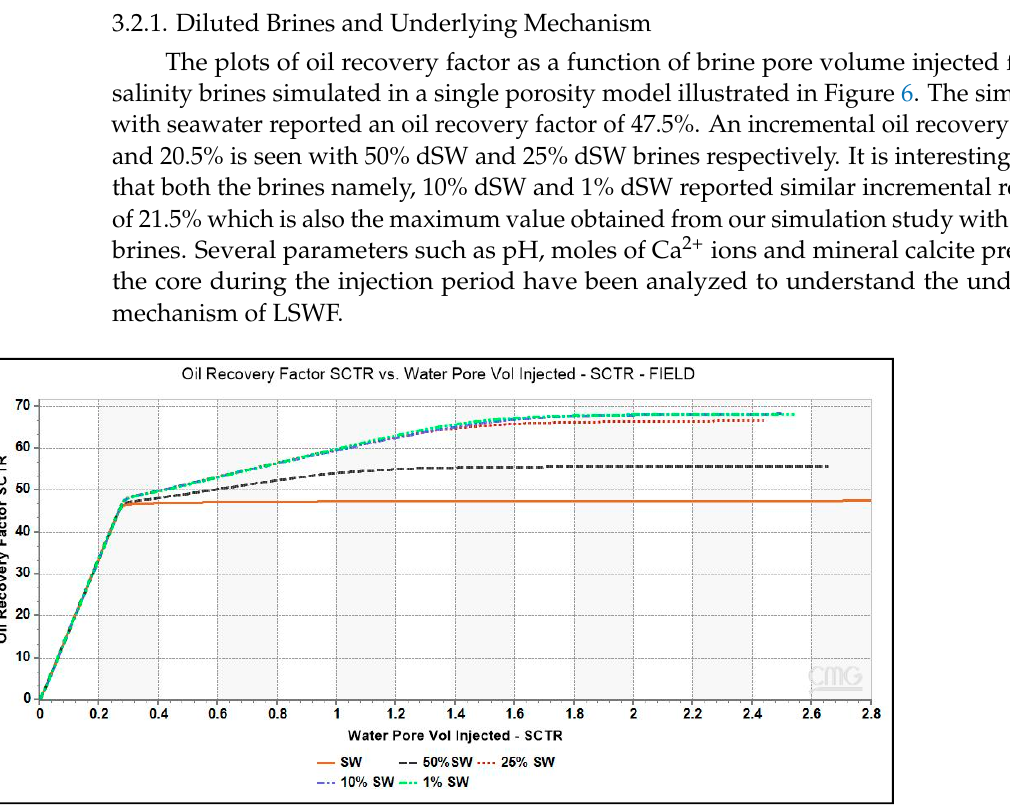
Figure 6. Oil Recovery factor vs. brine pore volume injected for various diluted brines. LS brines, 1% dSW and 10% dSW showed maximum incremental oil recovery.